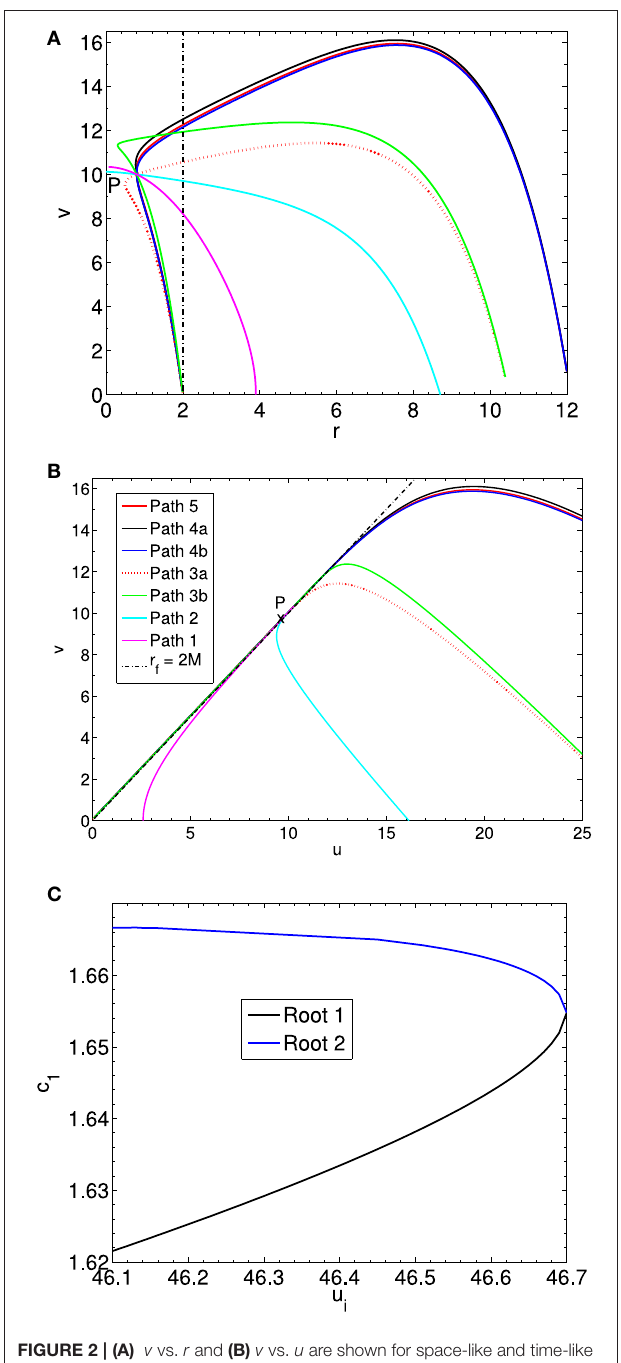
9.995, v P 10.0) of r P 0.8, a = = = b ′ 7 , which is =